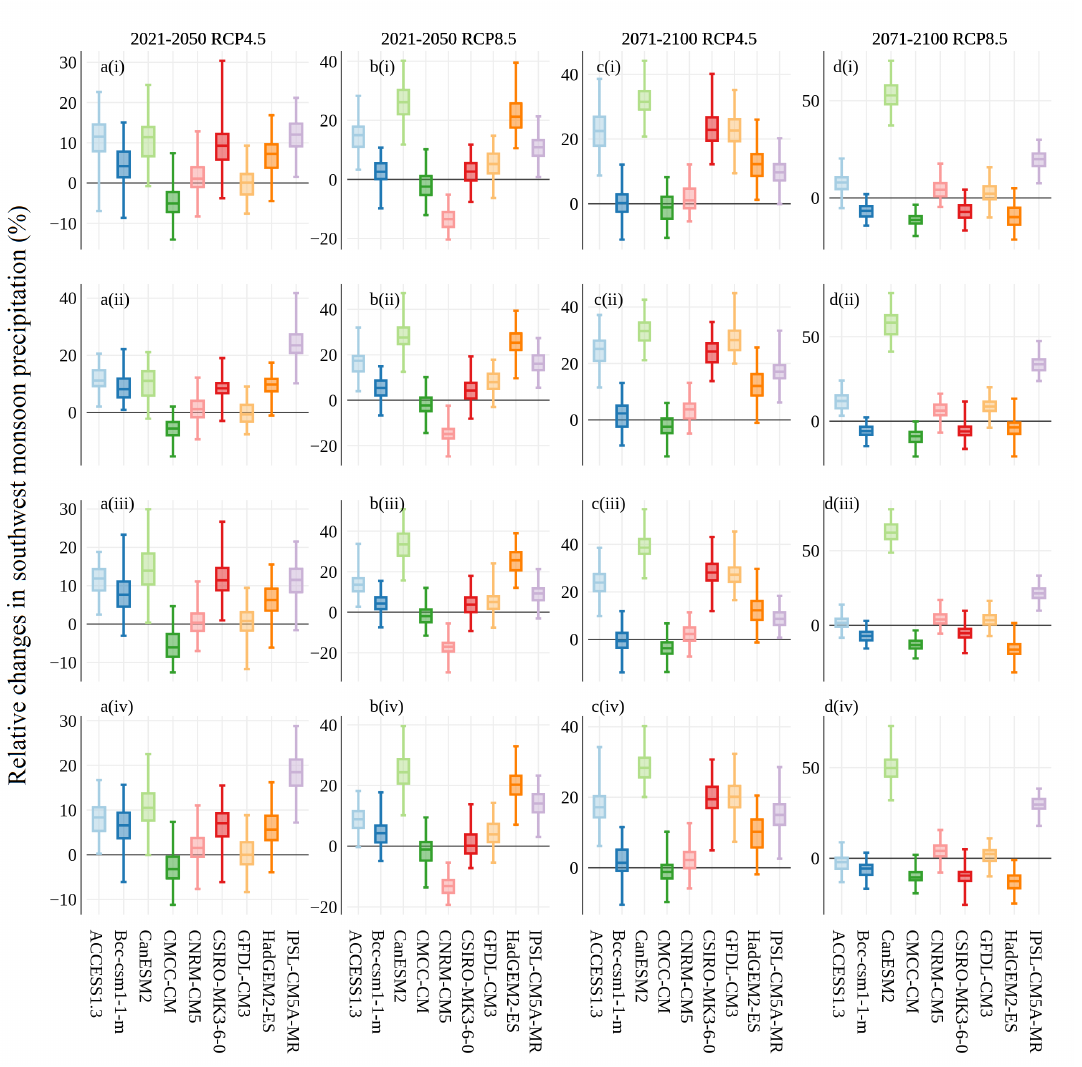
Figure 6. Relative changes (%) in long-term average southwest monsoon precipitation from downscaled GCM data for: ( a ) 2021–2050 period under RCP4.5 scenario; ( b ) 2021–2050 period under RCP8.5 scenario; ( c ) 2071–2100 period under RCP4.5 scenario; and ( d ) 2071–2100 period under RCP8.5 scenario relative to observed values during 1985–2014. Rows ( i – iv ) denote results for stations S06, S23, S24, and S25, respectively. The bottom, middle, and top of the box denote the first, second, and third quartiles, respectively. The lower and upper ends of the whiskers represent the minimum and maximum values,